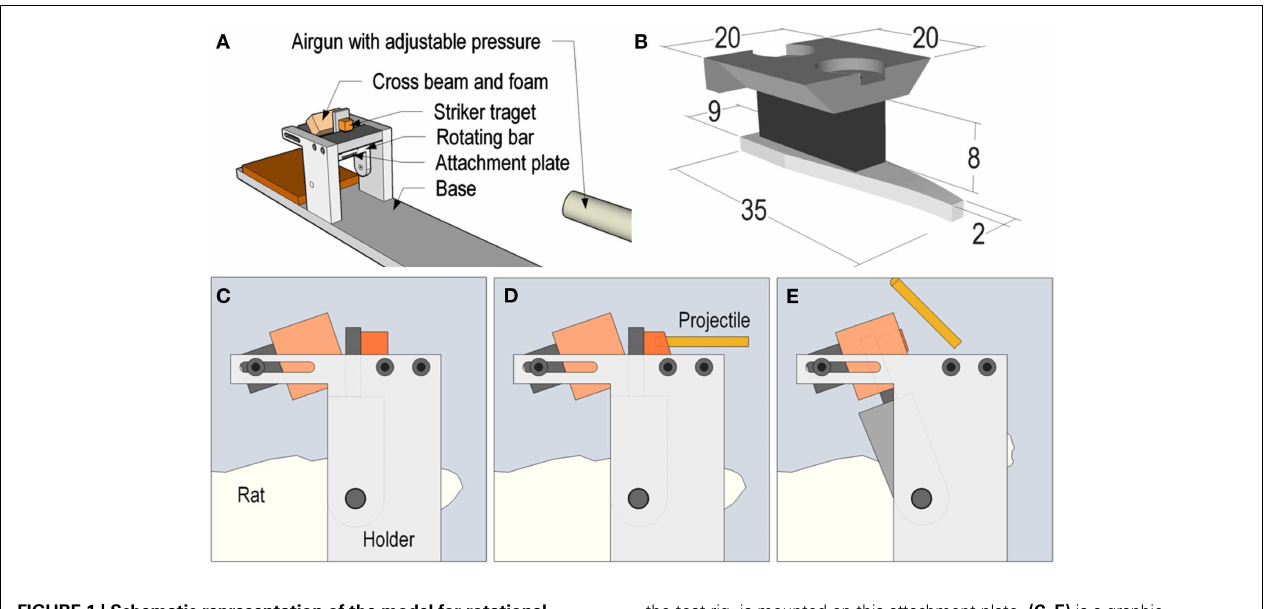
FIGURE 1 | Schematic representation of the model for rotational TBI. In Figure (A) , the relation between the accelerator (modified air gun) and the head holder is represented.The attachment plate for the rat head is shown in (B) . A metallic level, which extends to the top of